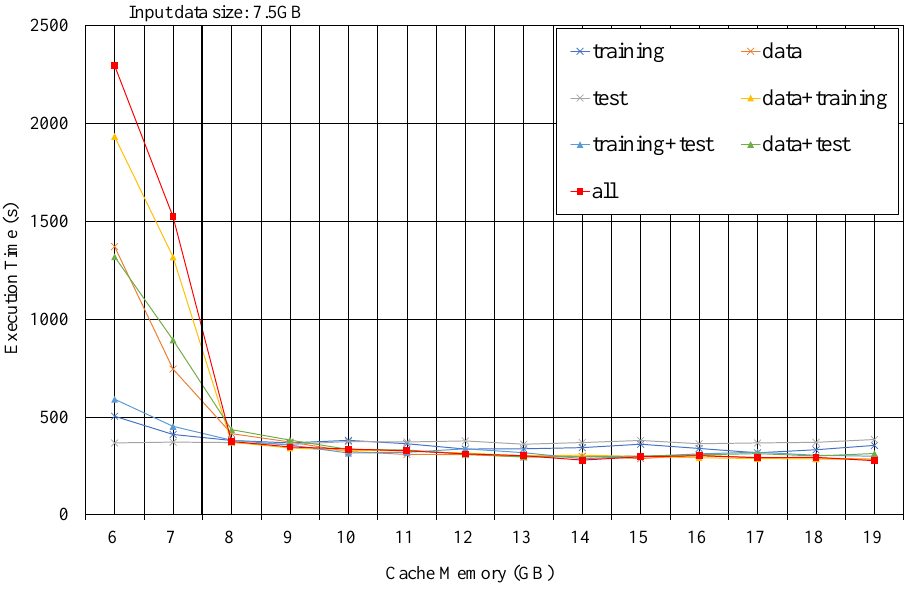
Figure 3. Execution time of logistic regression on 7 different caching